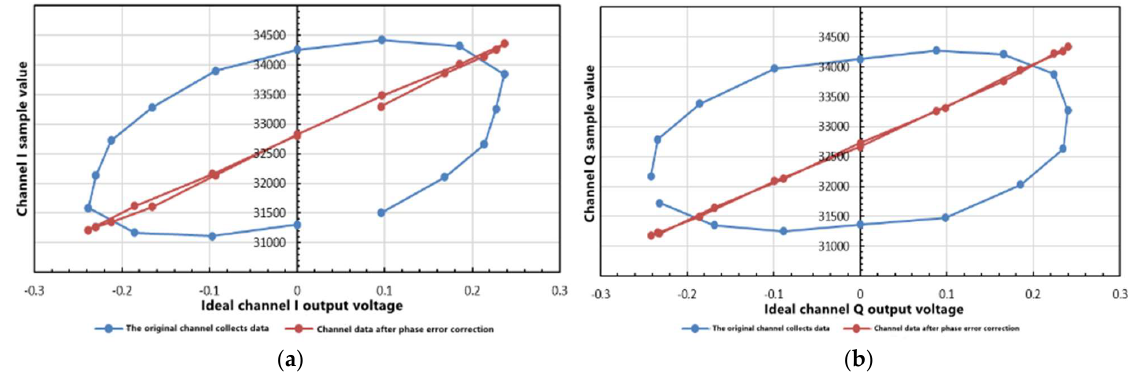
Figure 4. ( a ) The comparison of original sampling data of the I channel before and after correcting the phase error; ( b ) The comparison of the original sampling data of the Q channel before and after correcting the phase error.